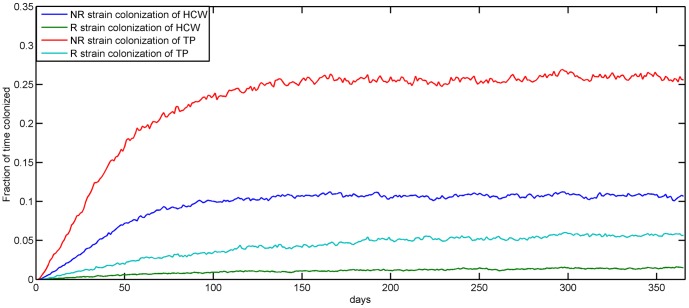
Contamination durations of healthcare workers and transmission points.The fraction of time healthcare workers (HCW) and transmission points (TP) remain contaminated with non-resistant (N) and resistant (R) strains each day averaged over 500 simulations.